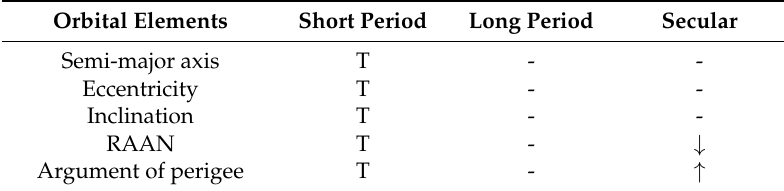
Table 2. Law of the GEO SAR orbital elements variations under the influences of the J 2 term Orbital Elements Short Period Long Period Secular Semi-major axis T - - Eccentricity T - - Inclination T - - RAAN T - ↓ Argument of perigee T - ↑